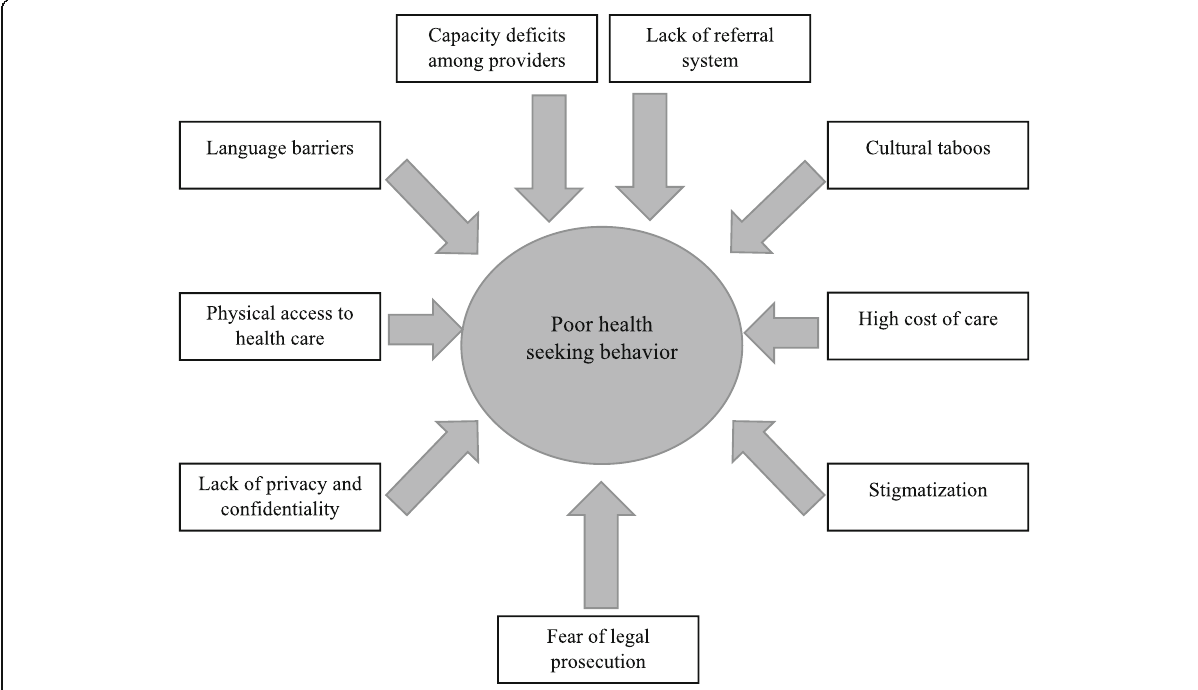
Fig. 1 Summary of barriers to health seeking in public health facilities among Somali Women living with FGM/C in